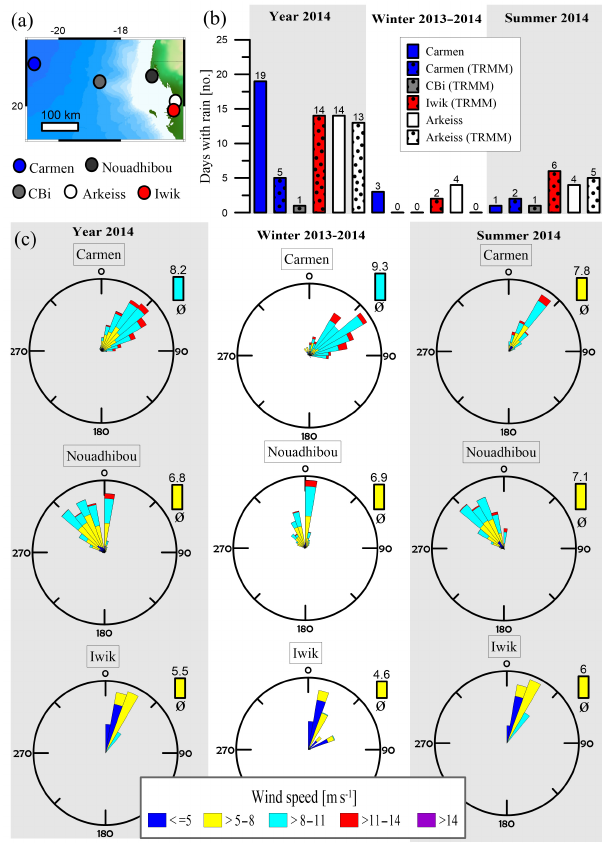
Figure 4. Meteorological data map (a) showing sites Carmen (CB), CBi, Iwik, Nouâdhibou and Arkeiss under investigation; (b) pre- cipitation at sites Carmen (CB), CBi, Iwik and Arkeiss; (c) wind direction and speed at sites Carmen (CB), Nouâdhibou and Iwik.